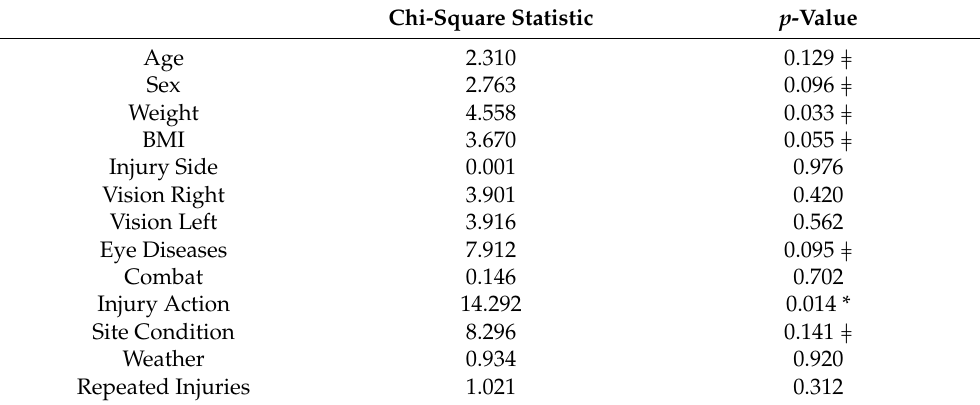
Table 2. Results of univariate logistic regression analysis of 287 knee injury questionnaires.